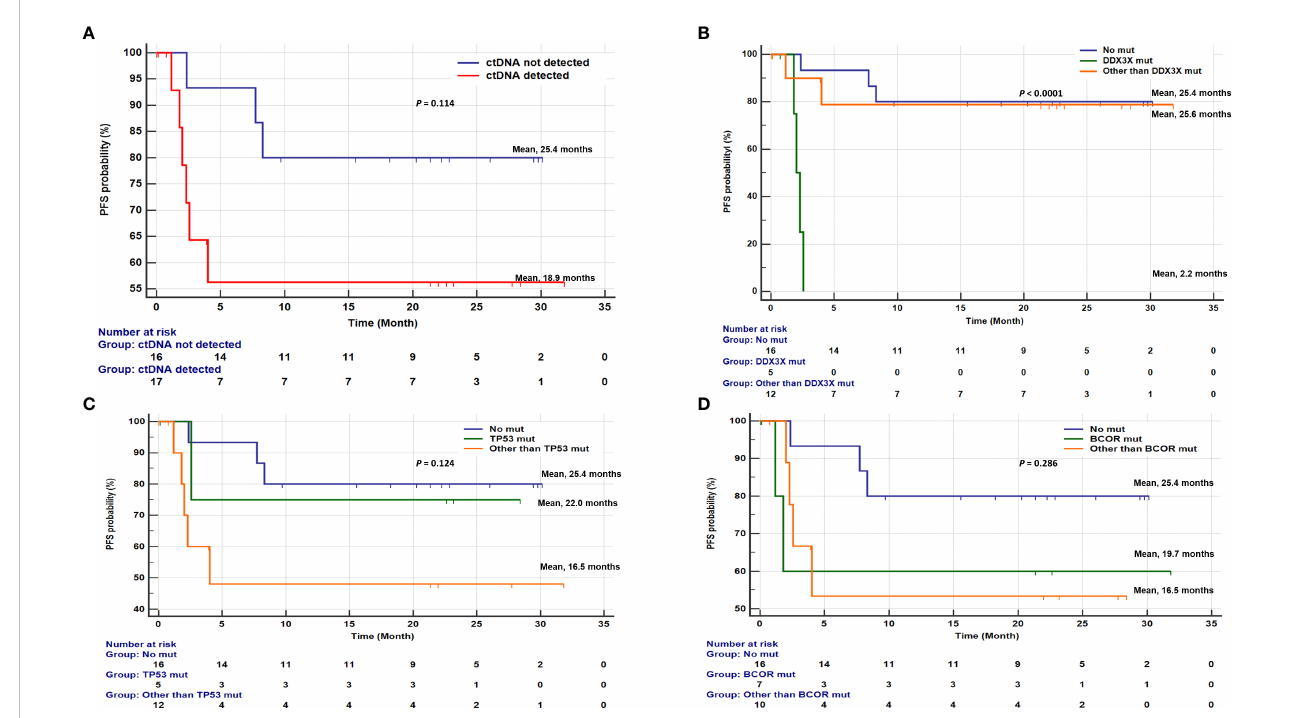
FIGURE 5 Kaplan-Meier curves for progression-free survival (PFS) of 33 newly diagnosed ENKTL patients. (A) Detection of ctDNA mutations in pretreatment blood sample was associated with progression-free survival (PFS) (median PFS, 18.9 months vs 25.4 months; P=0.114). Association of PFS between DDX3X, TP53, and BCOR gene mutations. (B) Comparison of PFS among patients without any mutation, with DDX3X mutation, and with mutations in other than DDX3X (median PFS, 25.4 months vs. 2.2 months vs. 25.6 months; P<0.0001). (C) Comparison of PFS among patients without any mutation, with TP53 mutation, and with mutations in other than TP53 (median PFS, 25.4 months vs. 22.0 months vs. 16.5 months; P=0.124). (D) Comparison of PFS among patients without any mutation, with BCOR mutation, and with mutations in other than BCOR (median PFS, 25.4 months vs. 19.7 months vs. 16.5 months; P=0.286).